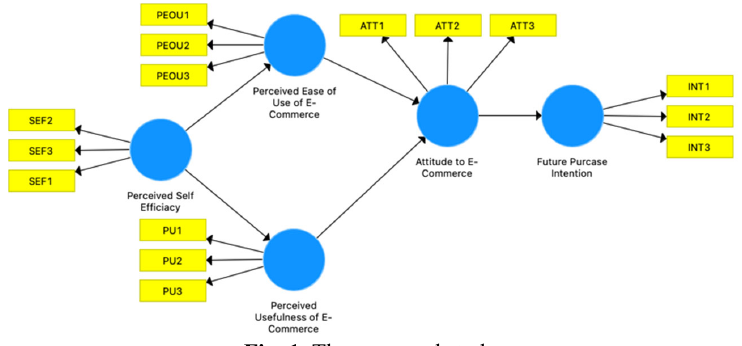
Fig. 1. The proposed